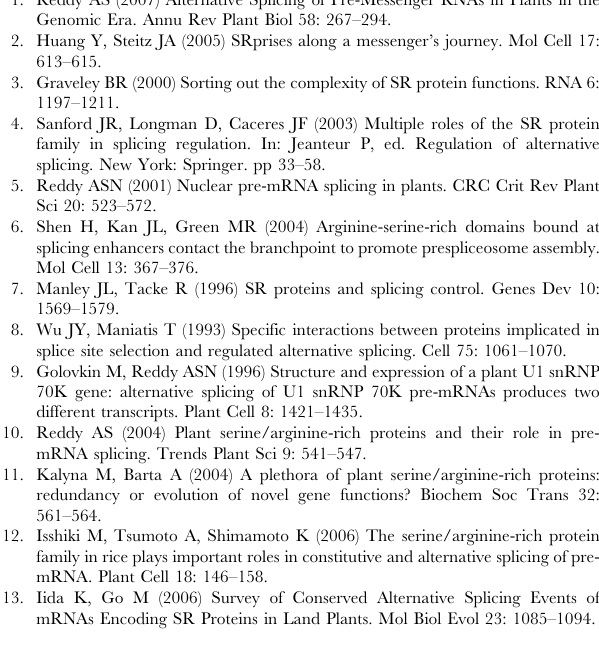
Table S3 Sequences of gene-specific primers of Arabidopsis SR, flowering pathway and leaf morphology